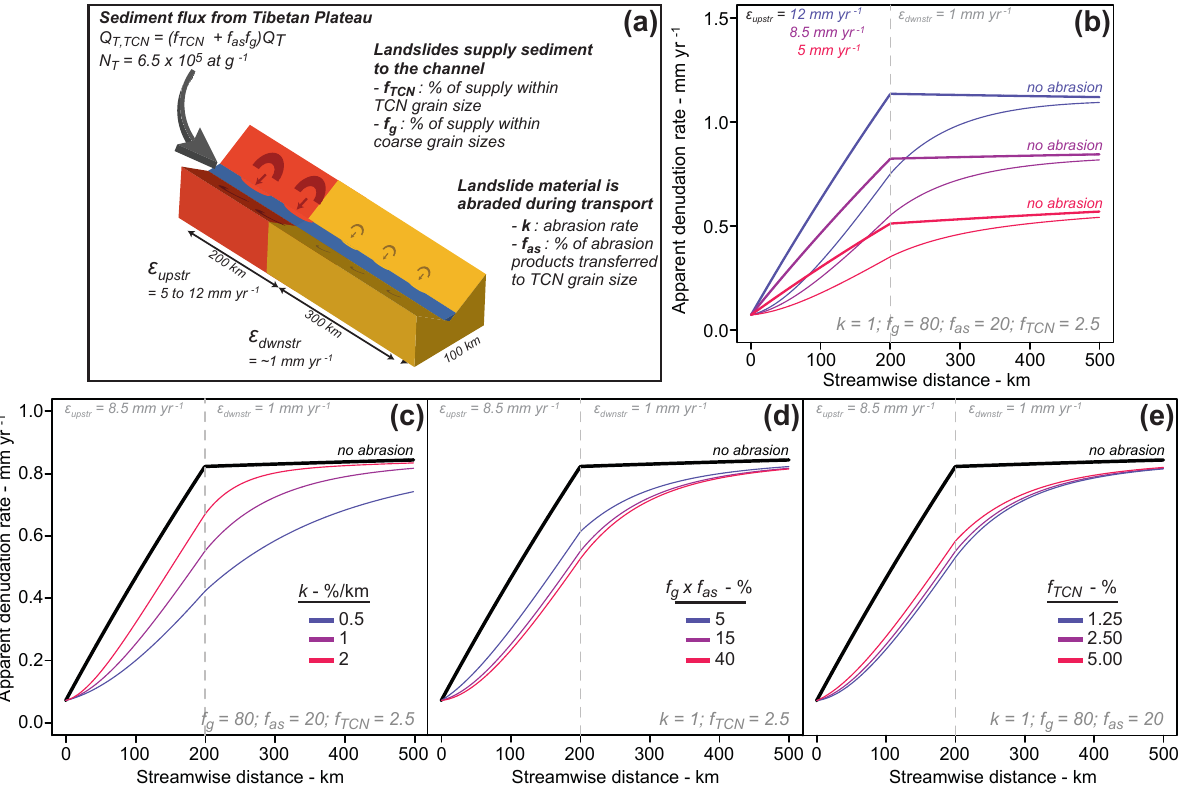
Figure 7. (a) Schematic of the modeled river reach: main boundary conditions and process parameters used in the model. Panels (b) to (e) are abrasion model results showing the apparent 10 Be denudation rate reconstructed from river sediments within the sand fraction in case of abrasion compared to the no-abrasion case (thick line). The sensitivity to changes in different parameters has been explored: (b) sensitivity to changes in absolute erosion rates over the modeled reach, (c) sensitivity to changes in the abrasion rate coefficient k , (d) sensitivity to changes in the product between the initial fraction of coarse material (>2mm) delivered to the channel f g and the fraction of this coarse material that is ultimately transferred to the TCN sampled and measured fraction f as , and (e) sensitivity to changes in the initial fraction of sediment delivered by landslides directly within the TCN grain size fraction f TCN . More information on the model setup and results can be found in the